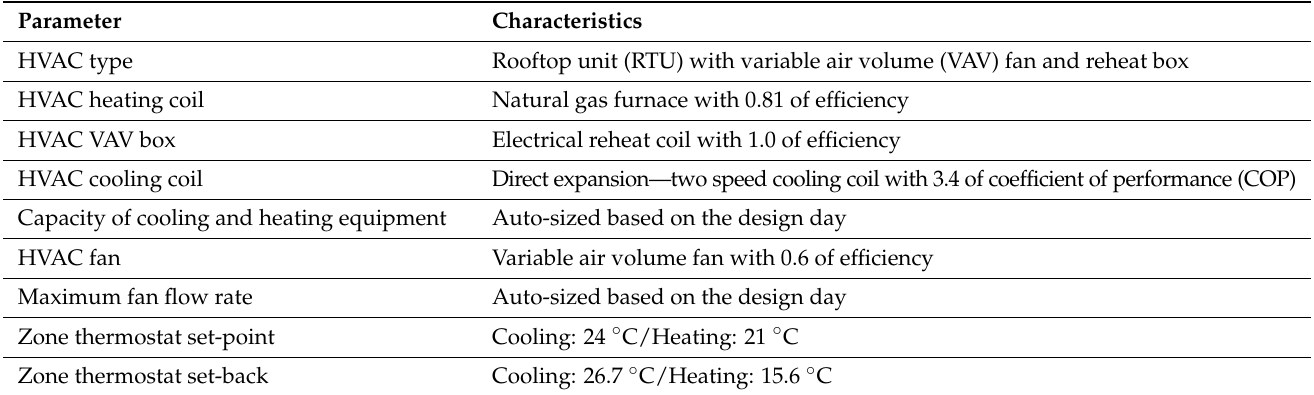
Table 3. HVAC input parameter of the medium-sized office model [22,27].